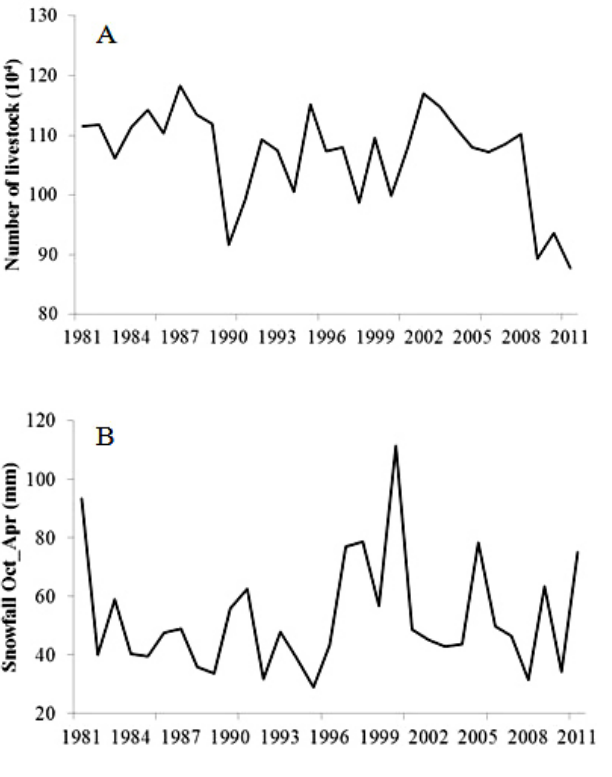
Fig. 4 . The time series of livestock population (A) and snow depth (B) in Nagqu County